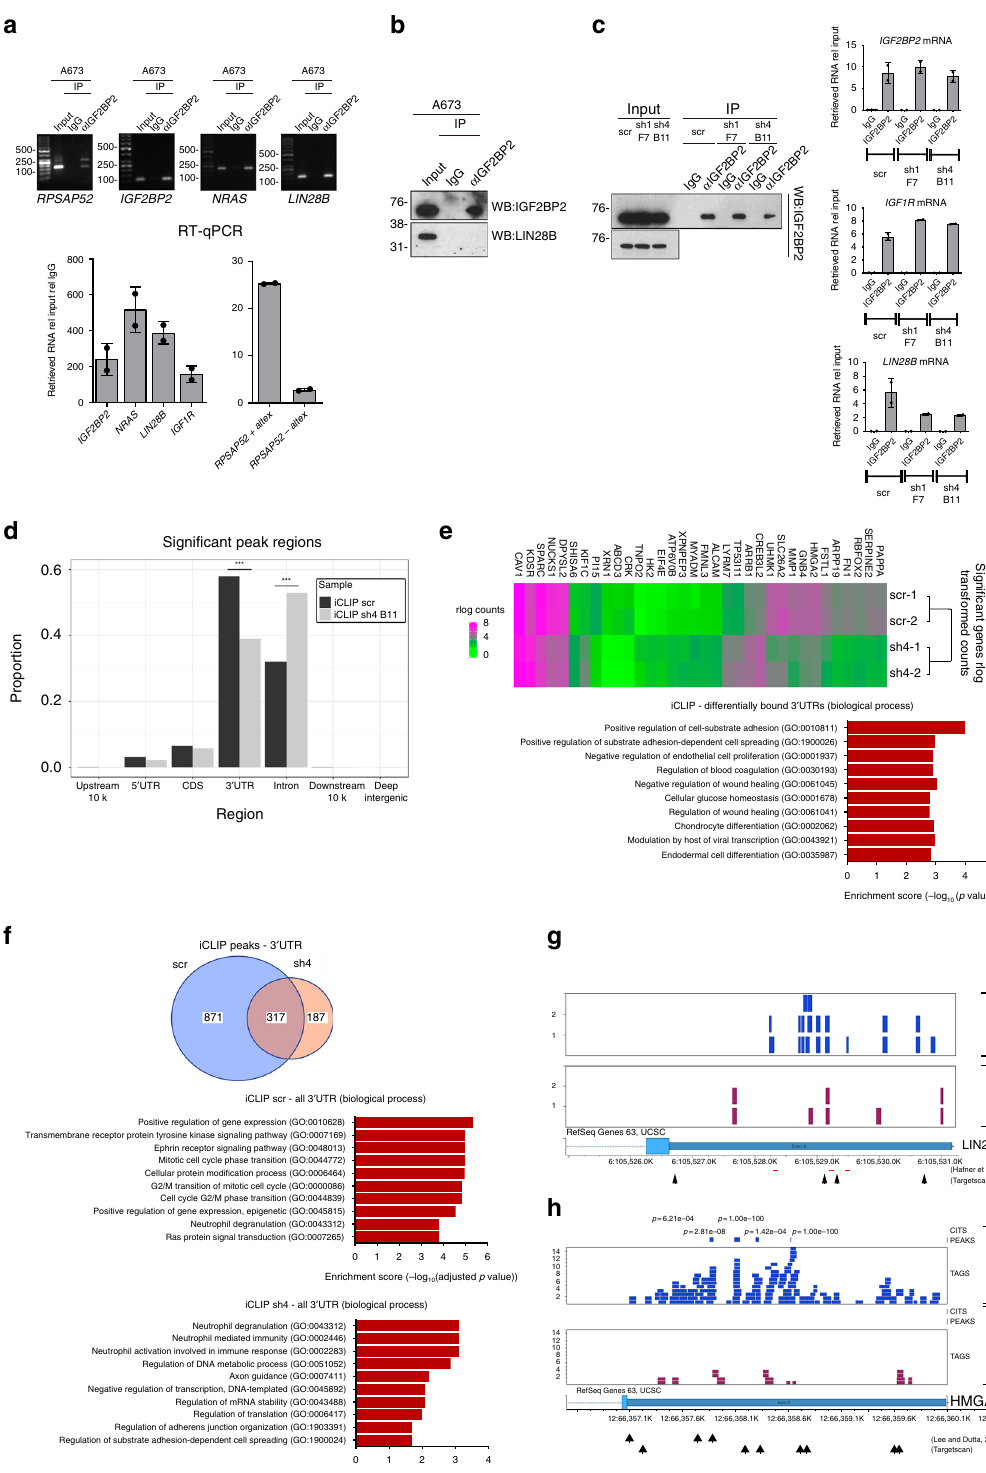
unexplored. Our previous work had shown that the transcribed pseudogene RPSAP52 enhances HMGA2 transcription through the formation of an R loop structure 23 . We have further explored the impact of RPSAP52 expression in cell physiology and propose a mechanism of action that also in fl uences post-transcriptional regulation in the cytoplasm through the interaction with the RNA binding protein IGF2BP2. Regulation of IGF2BP2 expression or